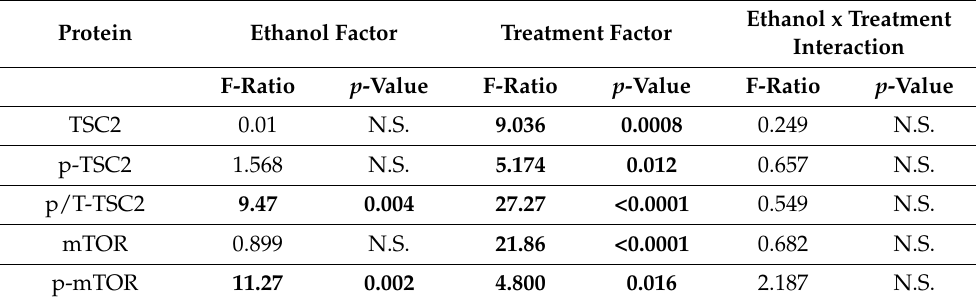
Table 4. Effects of In Vivo Ethanol Exposure and Ex Vivo Interventive Treatments on TSC2, mTOR, p70S6K, and RPS6 Signaling Mediators in Frontal Lobe Slice